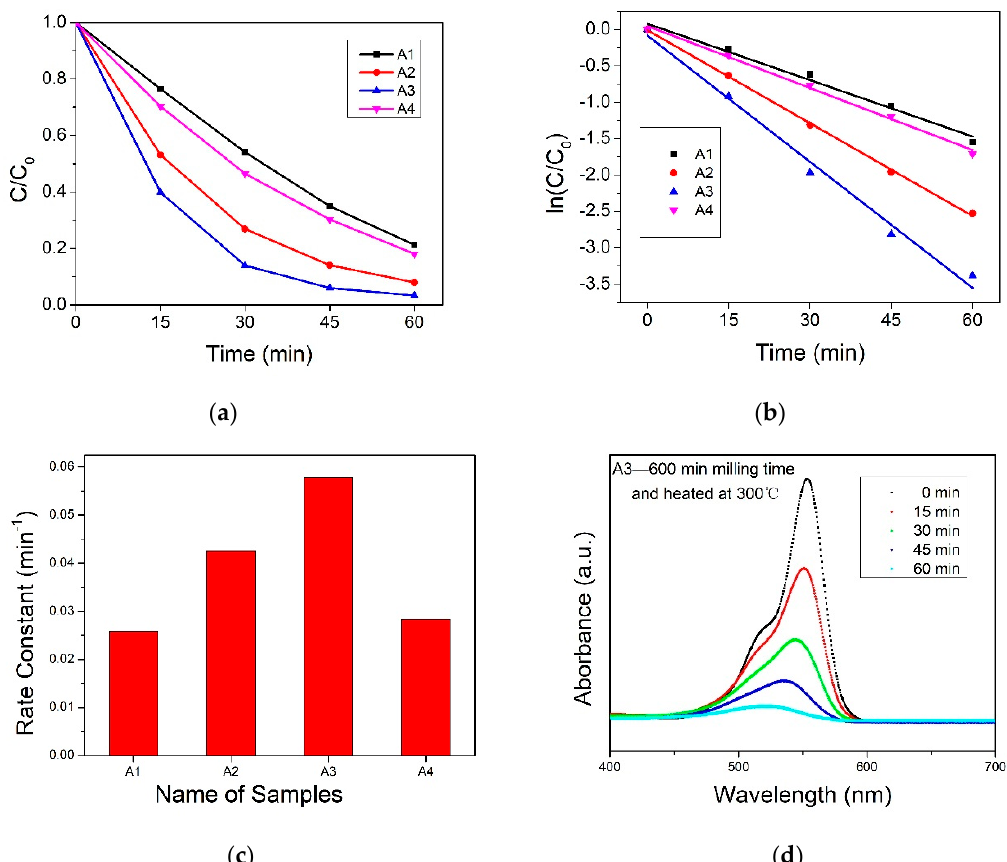
Figure 7. ( a ) RhB concentration with each ZnO photocatalyst as a function of the irradiation time; ( b ) first-order test of the photocatalytic reaction using the different photocatalyst; ( c ) photodegradation reaction rate constant histogram; and ( d ) UV-Vis spectrum of the RhB solution containing the A3 photocatalyst at different times.